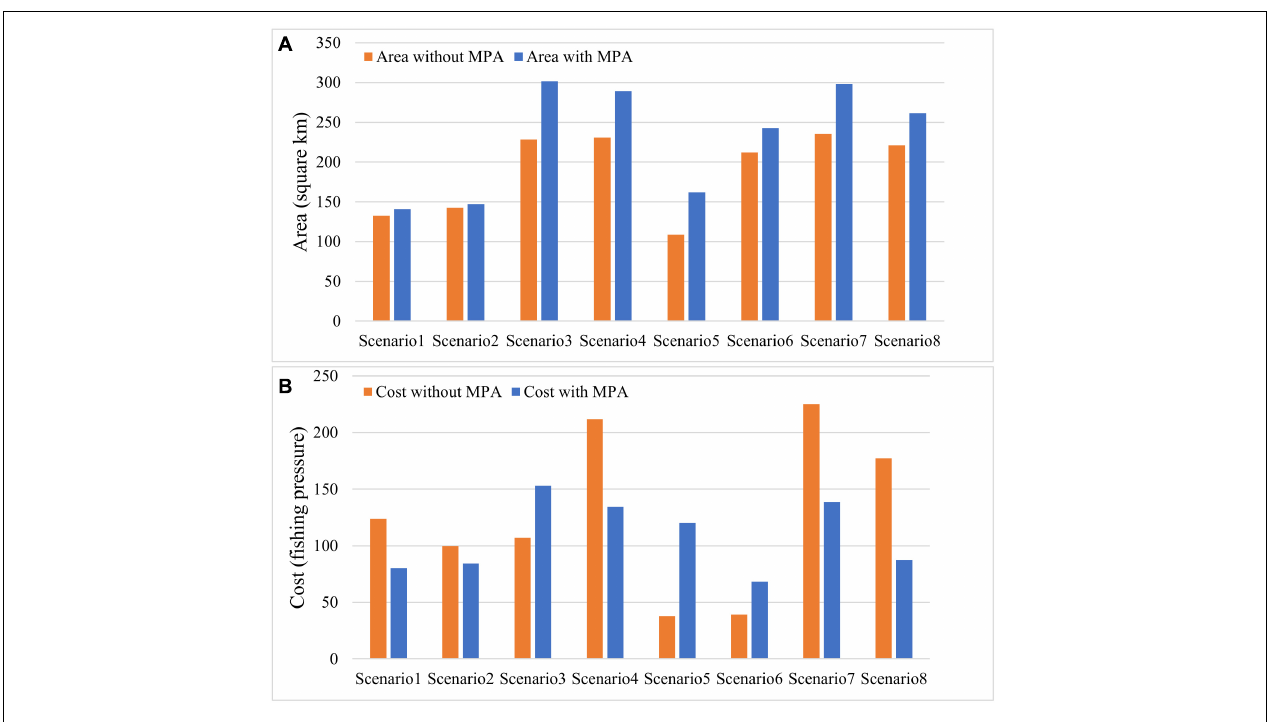
FIGURE 3 | Total area needed to achieve the conservation targets in the eight scenarios analyzed (A) ; and total cost in terms of artisanal fishing pressure displacement associated with the achievement of the conservation targets (B) . MPA, Marine Protected